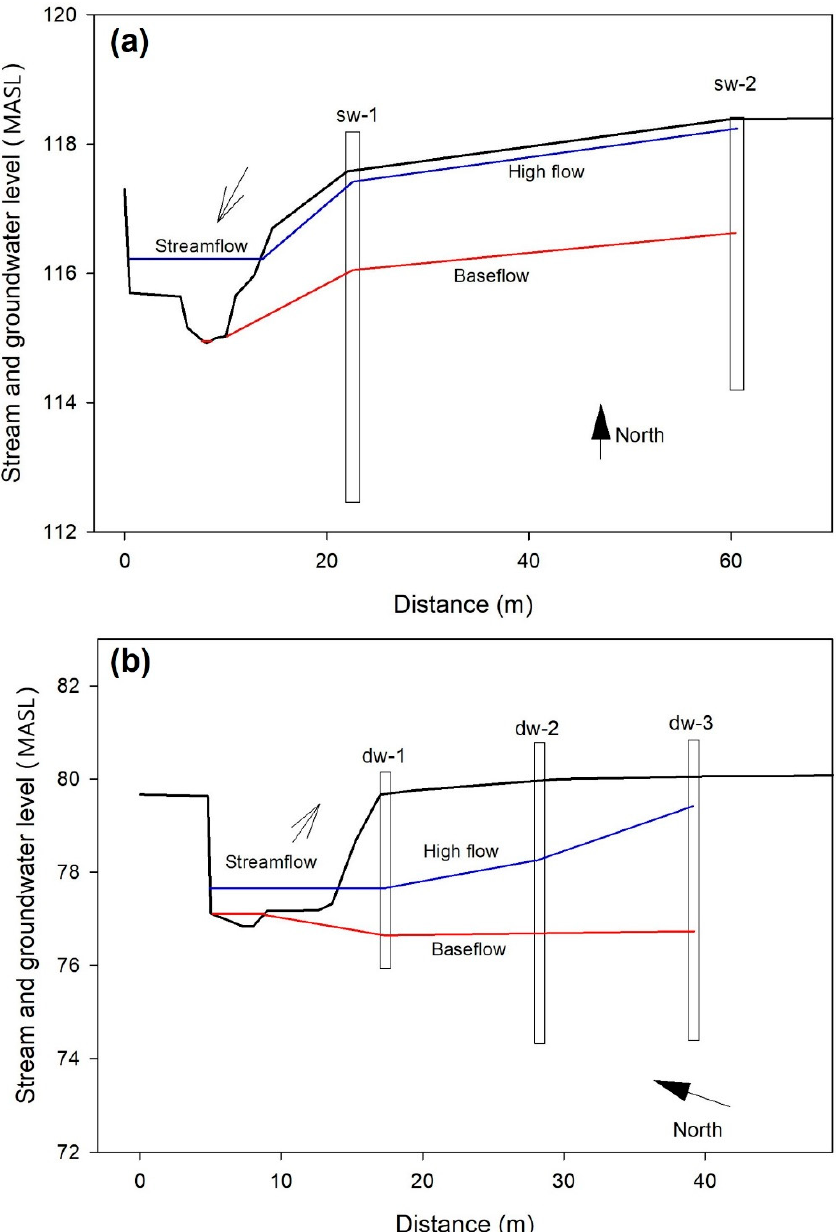
Figure 5. Surface water and groundwater levels (MASL) at baseflow (summer) and high streamflow (winter) conditions in ( a ) the Siletz River Volcanics formation at the OSU Sheep Center and ( b ) the alluvium in the Spencer formation at the OSU Dairy Center.